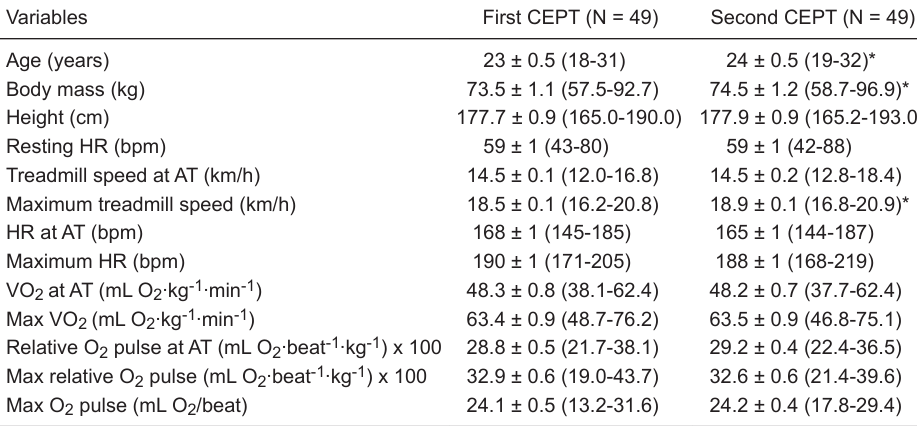
Table 1. Anthropometric and physiological variables of professional soccer players on the occasion of two CPET sessions.